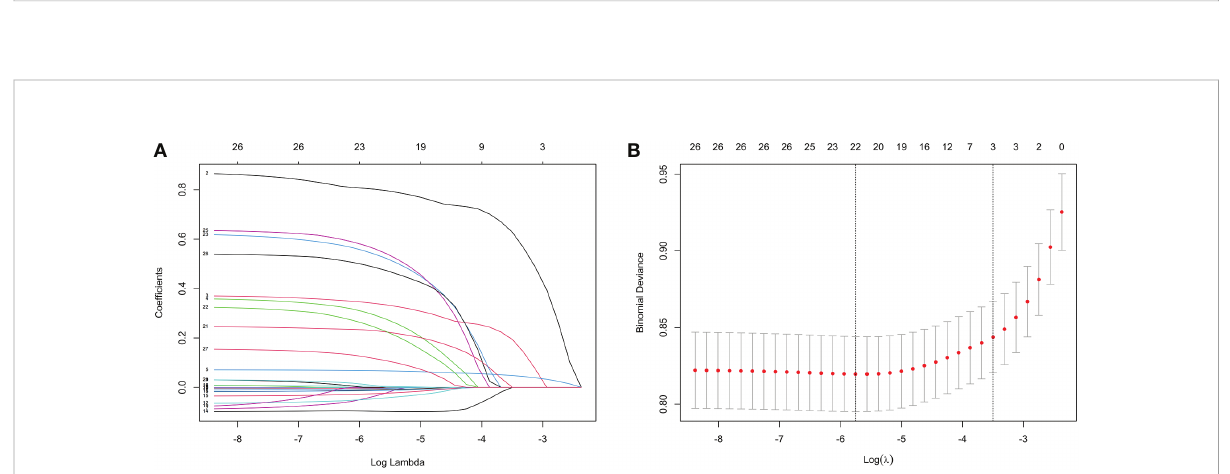
FIGURE 1 Features selection by LASSO. (A) LASSO coef fi cients pro fi les (y-axis) of the 26 features. The upper x-axis is the average numbers of predictors and the lower x-axis is the log( l ). (B) 10-fold cross-validation for tuning parameter selection in the LASSO